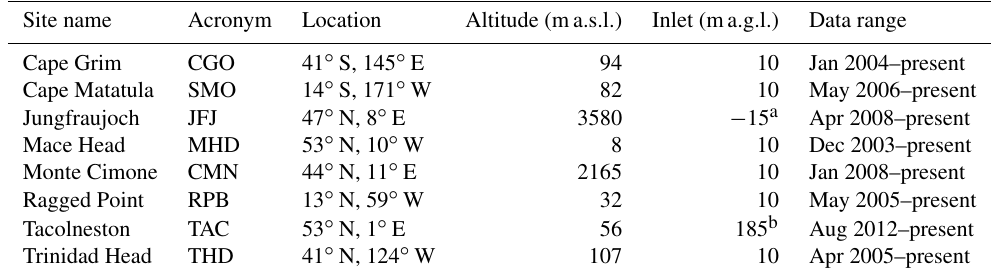
Table 1. Station names, locations and inlet heights for the instruments used to quantify global and regional PFC emissions. Note that for the mountain site, JFJ, the inlet is situated below the instrument.